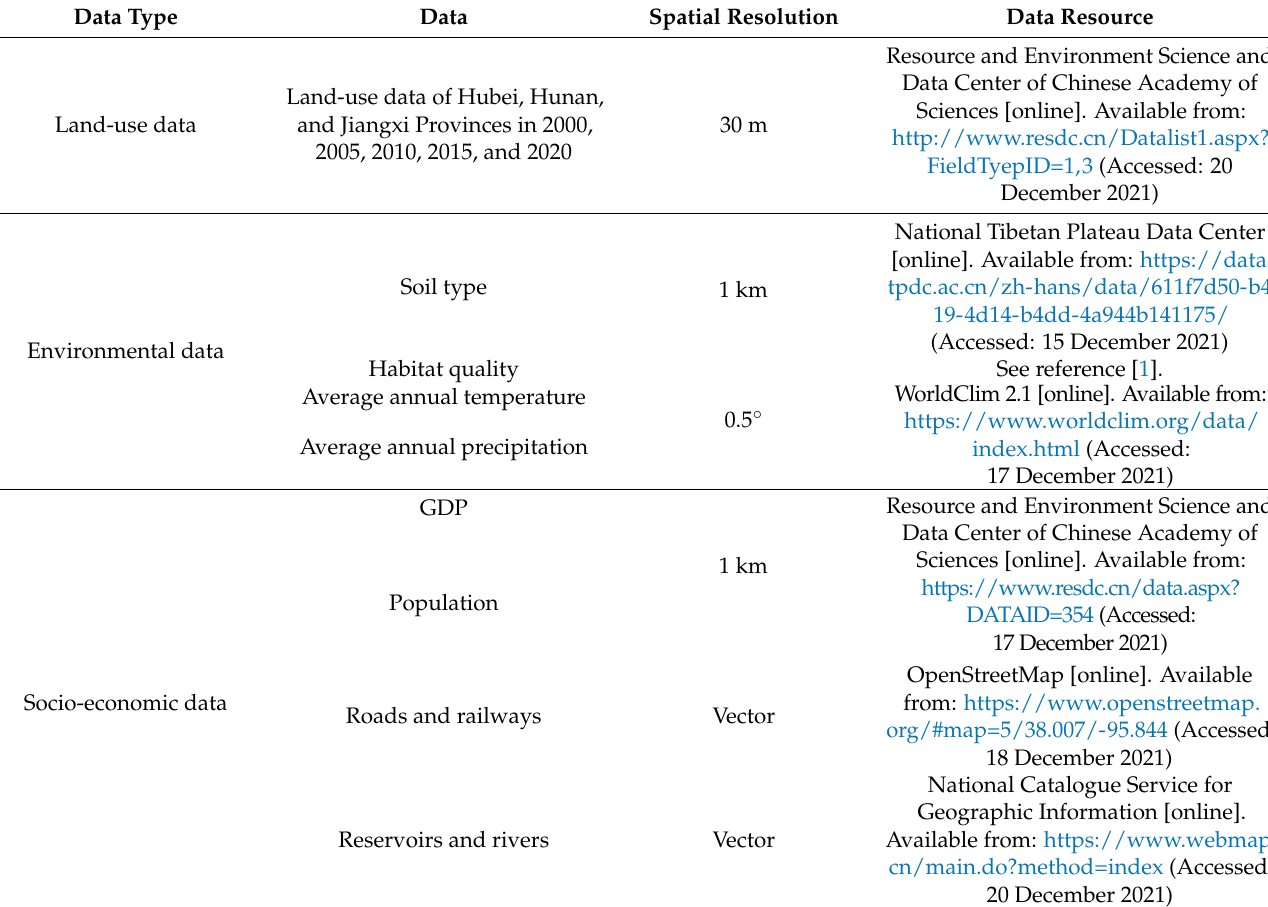
Table 1. Description of the data used for future land-use